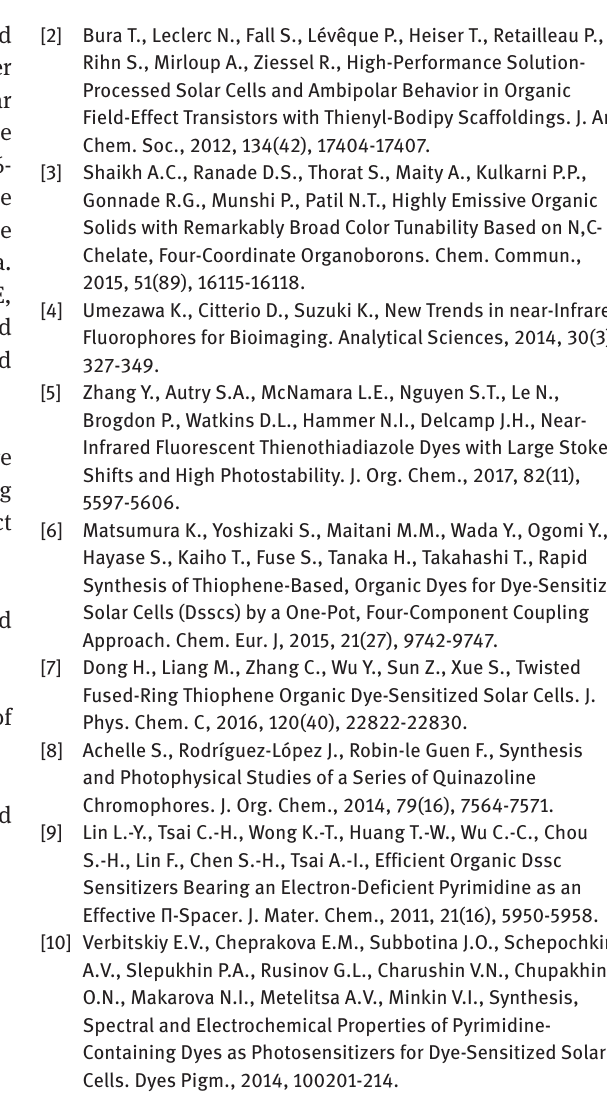
| of investigated dyes at B3LYP/6-31G** and RP